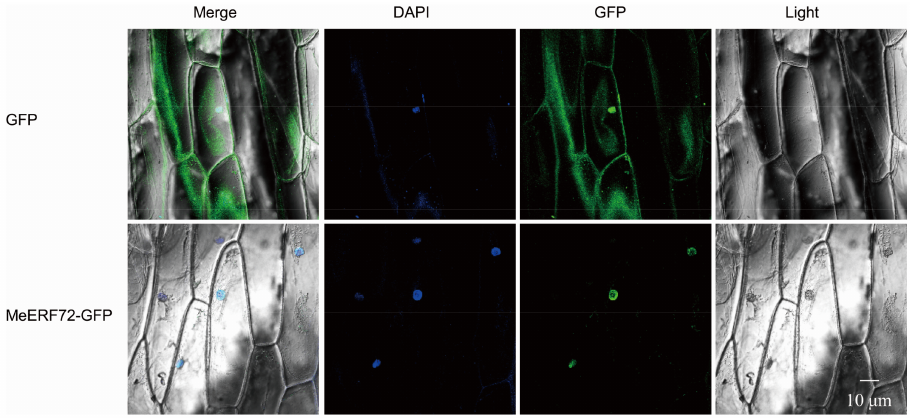
Figure 5. Nuclear localization of MeERF72. Top row/bottom row: the corresponding bright field, fluorescence, merged fluorescence image, and DAPI image of MeERF72-GFP/GFP